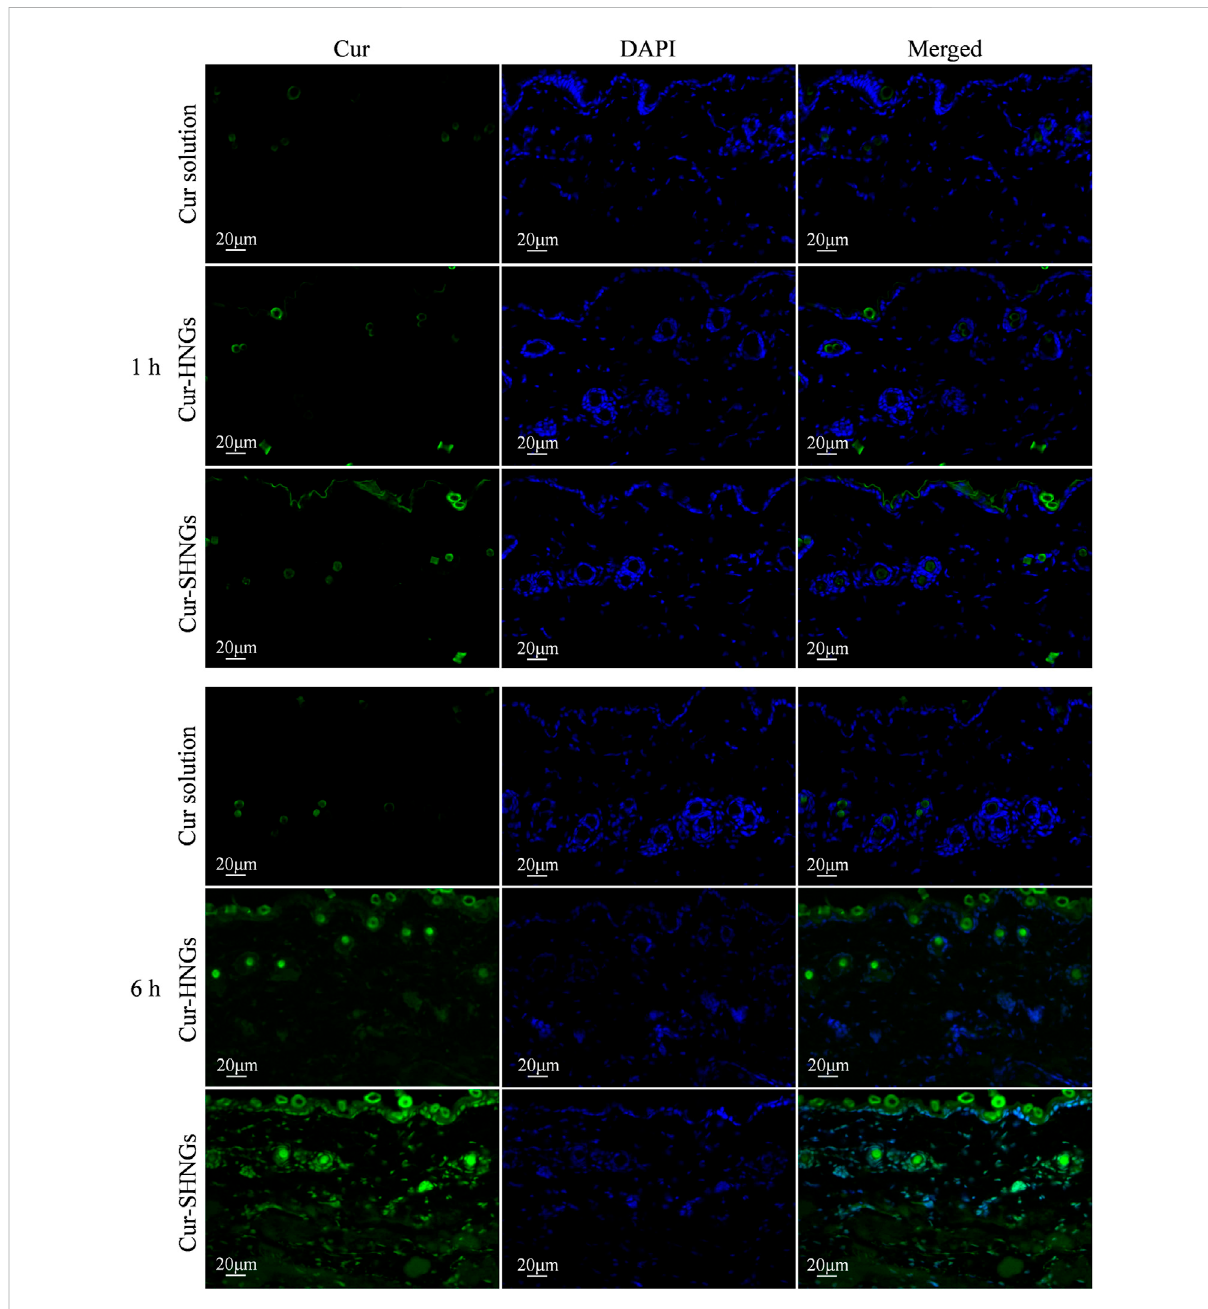
FIGURE 7 Fluorescence images of longitudinal sections of the skin incubated with Cur solution, Cur-HNGs and Cur-SHNGs at 1 and 6 h ( n = 3).